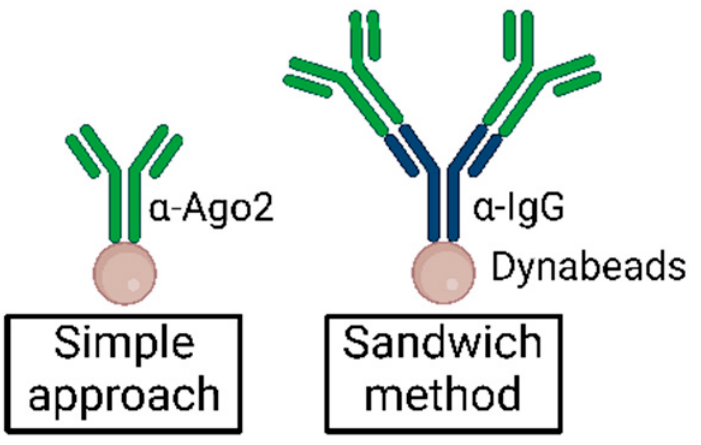
Table 7. RNA-Primer Mix for Reverse Transcription. Figure 7. Simplified illustration of the sandwich method as compared to standard antibody–bead suspension in immunoprecipitation.